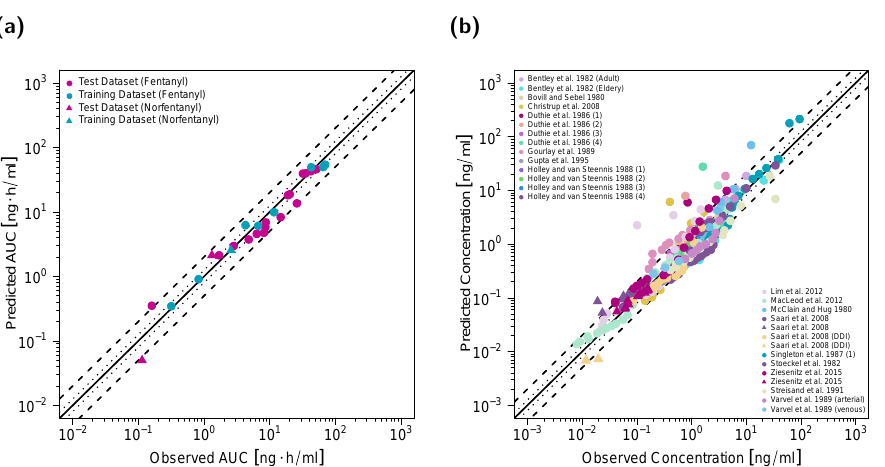
Figure 2. Predicted versus observed AUC last values of fentanyl and norfentanyl grouped by test and training dataset ( a ) and predicted versus observed plasma concentrations ( b ) for the adult PBPK model. In ( a ), each symbol represents the AUC last of a single plasma concentration–time profile (circles: fentanyl; triangles: norfentanyl). In ( b ), each symbol represents a single plasma concentration (circles: fentanyl; triangles: norfentanyl). The black solid lines mark the lines of identity. Black dotted lines indicate 1.25-fold, black dashed lines indicate 2-fold deviation. AUC last : area under the plasma concentration–time curve from the first to the last data